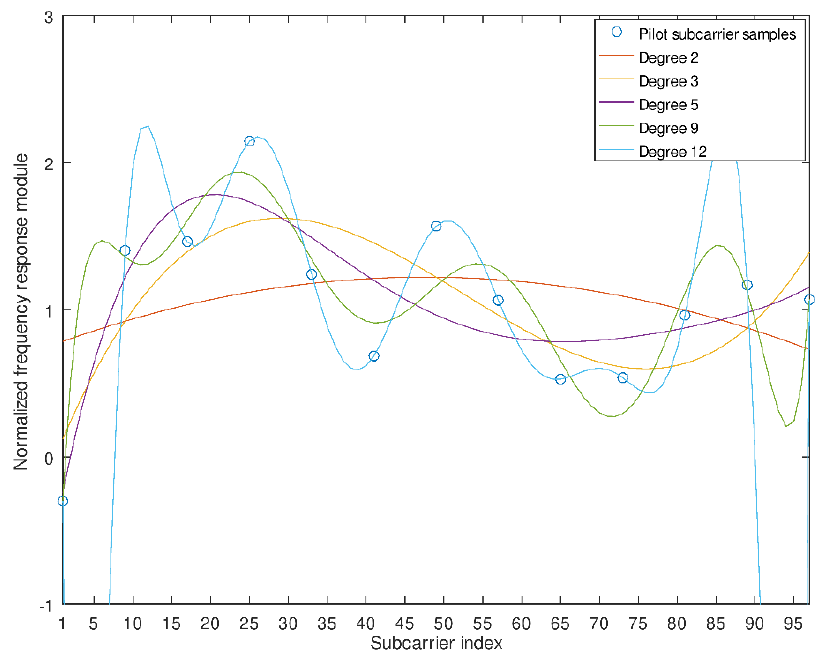
Figure 1. Obtained least square curve fitting for different degrees of the polynomial curve. The values in the Y -axis are given in linear units and normalized to the average frequency response.